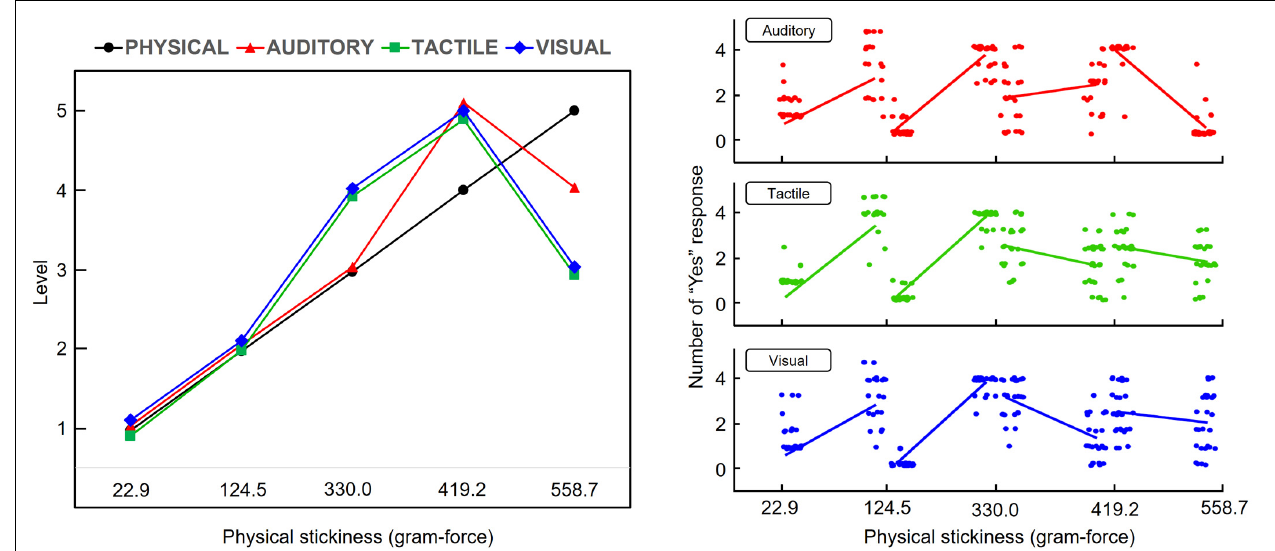
FIGURE 2 | Sequential order of physical and perceived intensities for the 5 sticky tapes. The left side: Based on participants’ responses to the 2-AFC task, the 5 stickiness intensities were sorted in ascending order for each modality condition. The right side: The number of “Yes” responses of 27 participants are depicted over the physical stickiness values. Each dot indicates a participant. The solid lines indicate the average number of “Yes” responses of each stimulus pair for both ascending and descending order.